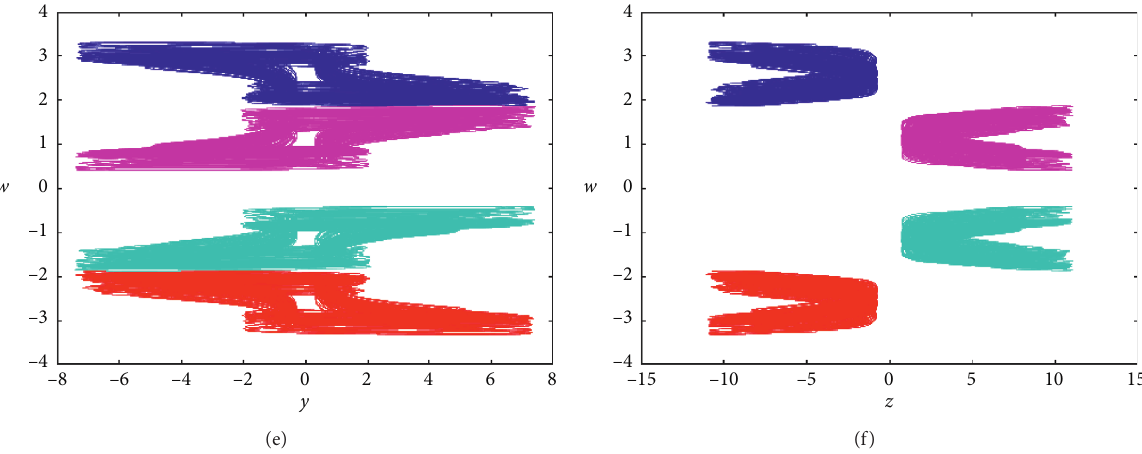
Figure 12: Phase portraits of symmetric coexisting infinitely many attractors in chaotic system (2) (the blue one starts from initial conditions ( 1 , 1 , − 10 , 1 ) , the red one starts from (− 1 , − 1 , − 10 , − 1 ) , the pink one starts from ( 10 , 20 , 15 , 2 ) , and the cyan one starts from (− 10 , − 20 , 15 , − 2 ) ).